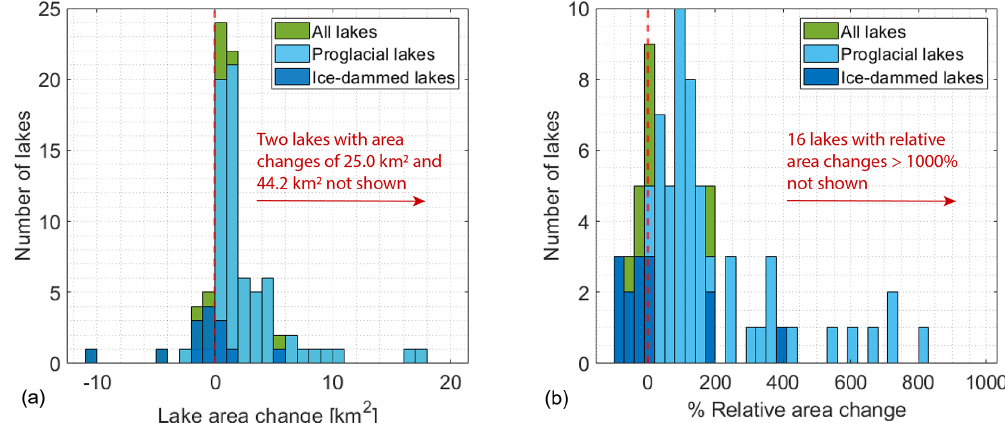
Figure 4. Distribution of proglacial and ice-dammed (a) absolute area change and (b) relative lake area change.